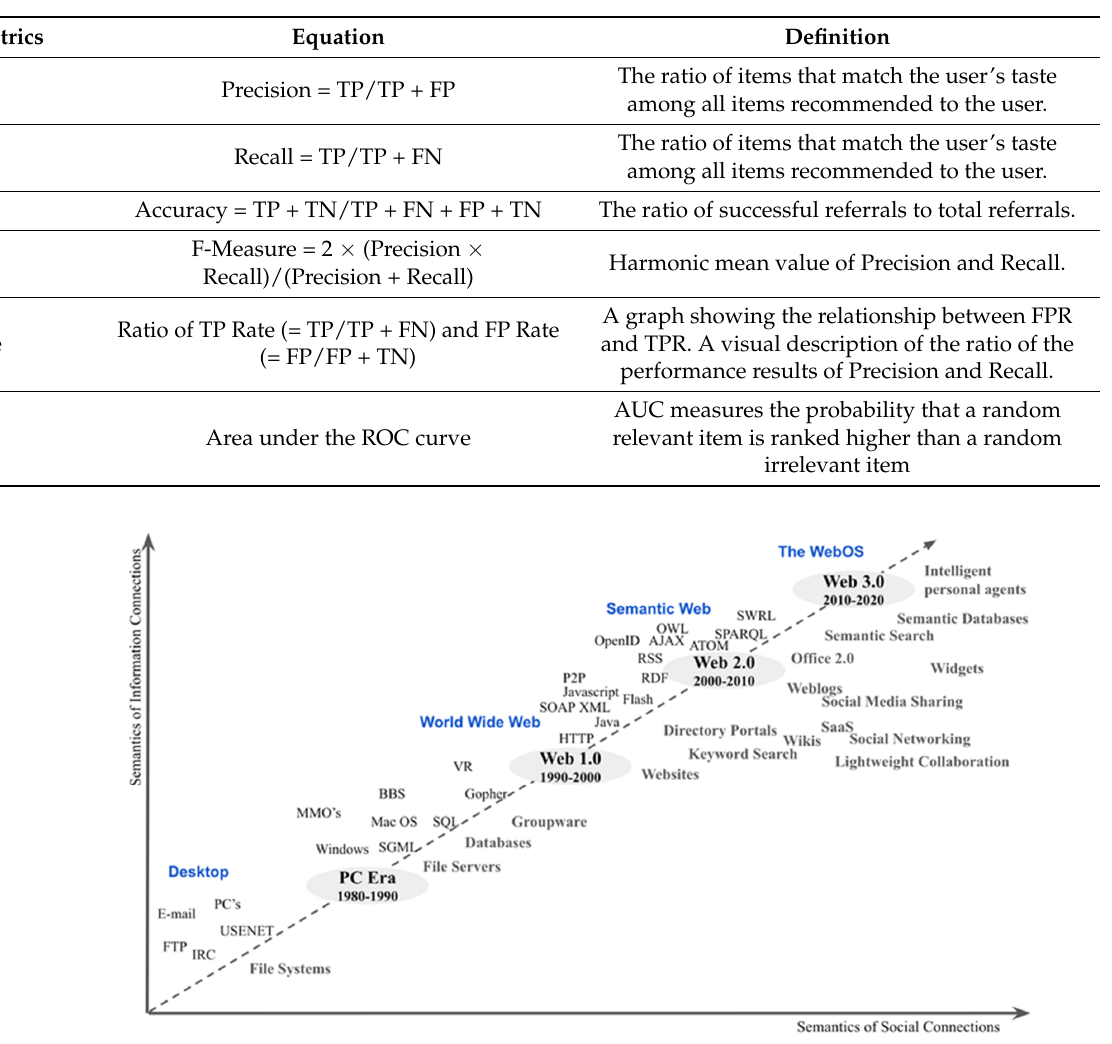
Table 3. Confusion matrix of recommendation systems.